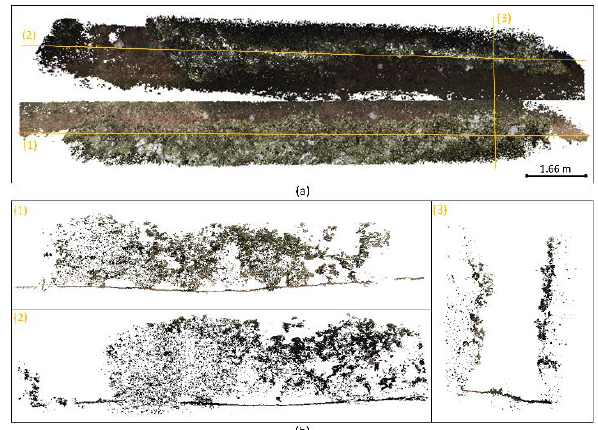
Figure 3. 3D reconstruction of the orange orchard: (a) top view of dense point cloud and cross section in green lines, and (b) longitudinal and transversal cross sections.